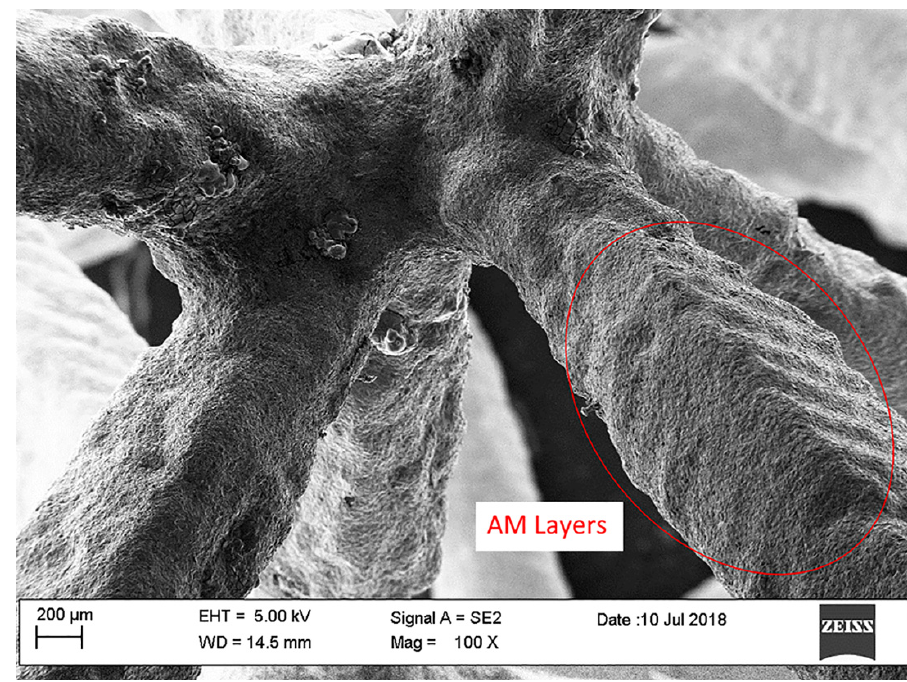
Figure 9. SEM image of 5 PPI-designed metal foam.